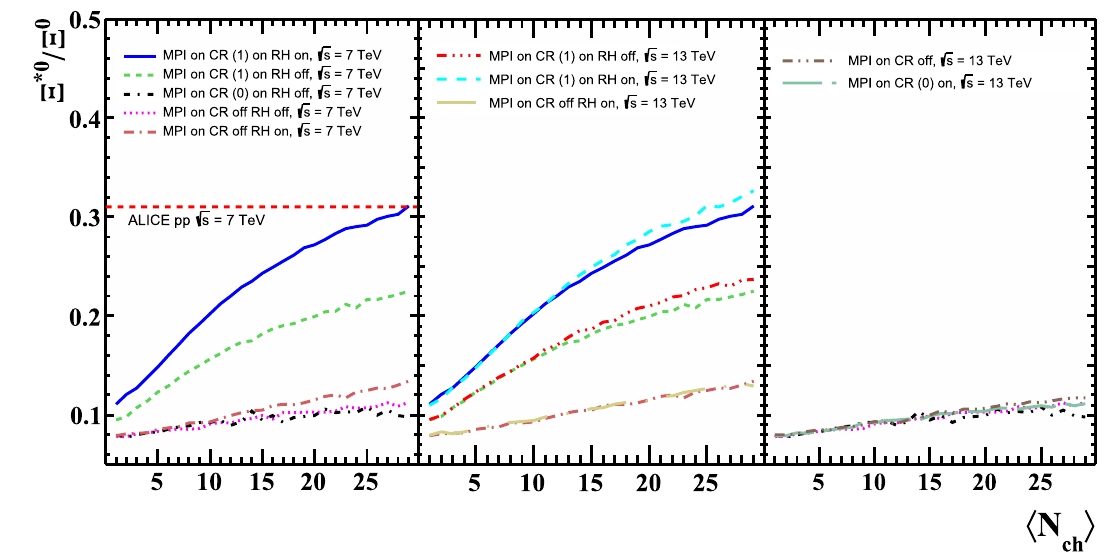
Fig. 10 p T -integrated ratio of (cid:9) 0 ∗ /(cid:9) 0 as a function of < N ch > in CR-off, CR(0) and CR(1) with RH. (Right panel) Comparison of ratios √ s = 7 TeV and 13 TeV for two other modes, for p–p collisions at p–p collisions. (Left panel) The ratios are compared for two different modes of color reconnections [CR-off, CR(0) and CR(1)] with (and namely CR-off and CR(0) without RH. The dashed line in the left panel √ s = 7 TeV. (Middle panel) The without) RH in p–p collisions at shows the value of (cid:9) 0 ∗ /(cid:9) 0 for minimum bias p–p collisions at √ s = 7 TeV and 13 TeV for ratios are compared for p–p collisions at TeV as obtained by the ALICE experiment